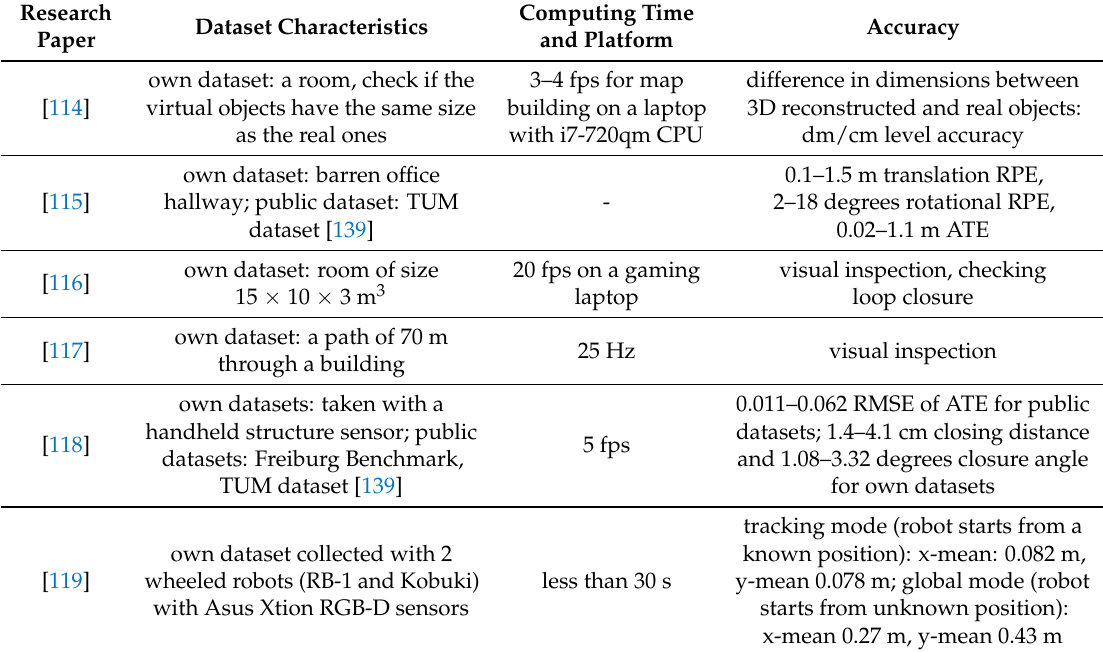
Table 16. Characteristics of indoor localization solutions with an existing/generated 3D model of the environment, 3D mobile cameras, real features, and traditional image